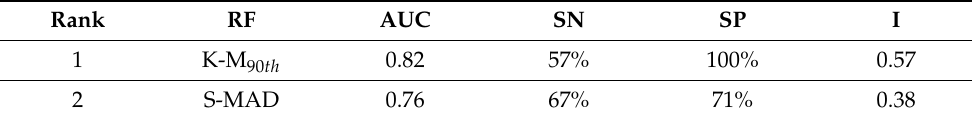
Table 3. Performance of the RFs finally selected in the CT discrimination study.